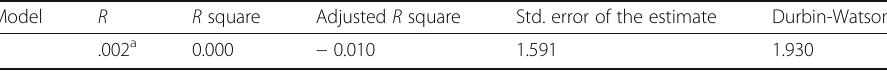
Table 16 Coefficient of determination ( R 2 ) — model summary